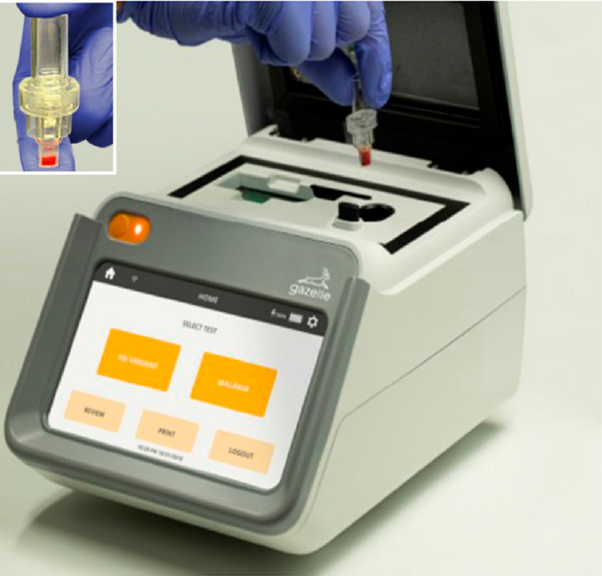
Figure 2. Cartridge loaded with blood sample at the time of insertion into the Gazelle™ device prior to hemozoin detection analysis. Image courtesy of Hemex Health.